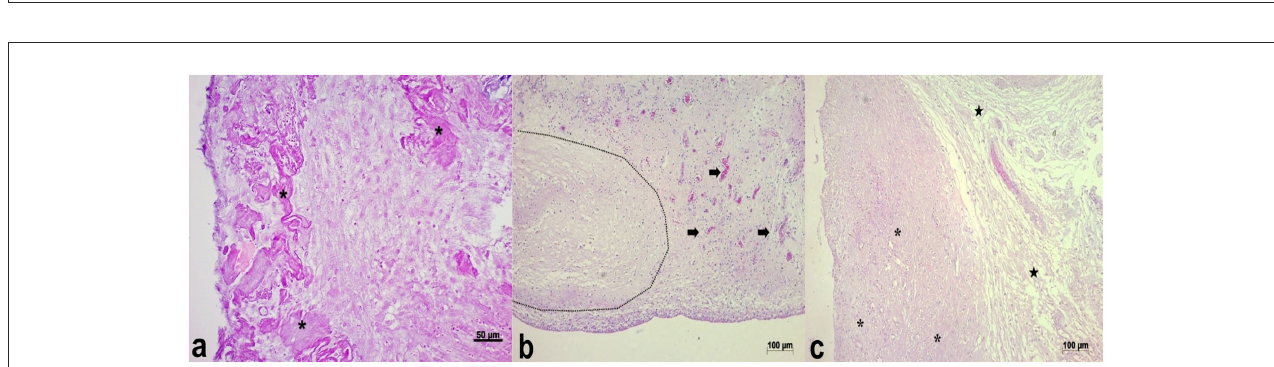
FIGURE3 Microscopic appearance of the induced membrane in chickens with bone cement at seven (a) , 15 (b) , and 21 (c) postoperative days. (a) Fibrovascular tissue surrounding fragmented and hypereosinophilic necrotic muscle fibers (asterisks). HE, 20x. (b) Marked proliferation of fibrous, disorganized and highly vascularized tissue (arrows) with an area of fibrocartilage (dotted line). HE, 10x. (c) Moderate, disorganized, and slightly vascularized fibrous tissue proliferation (asterisks), and loose connective tissue (stars) close to skeletal muscle tissue. HE, 5x.